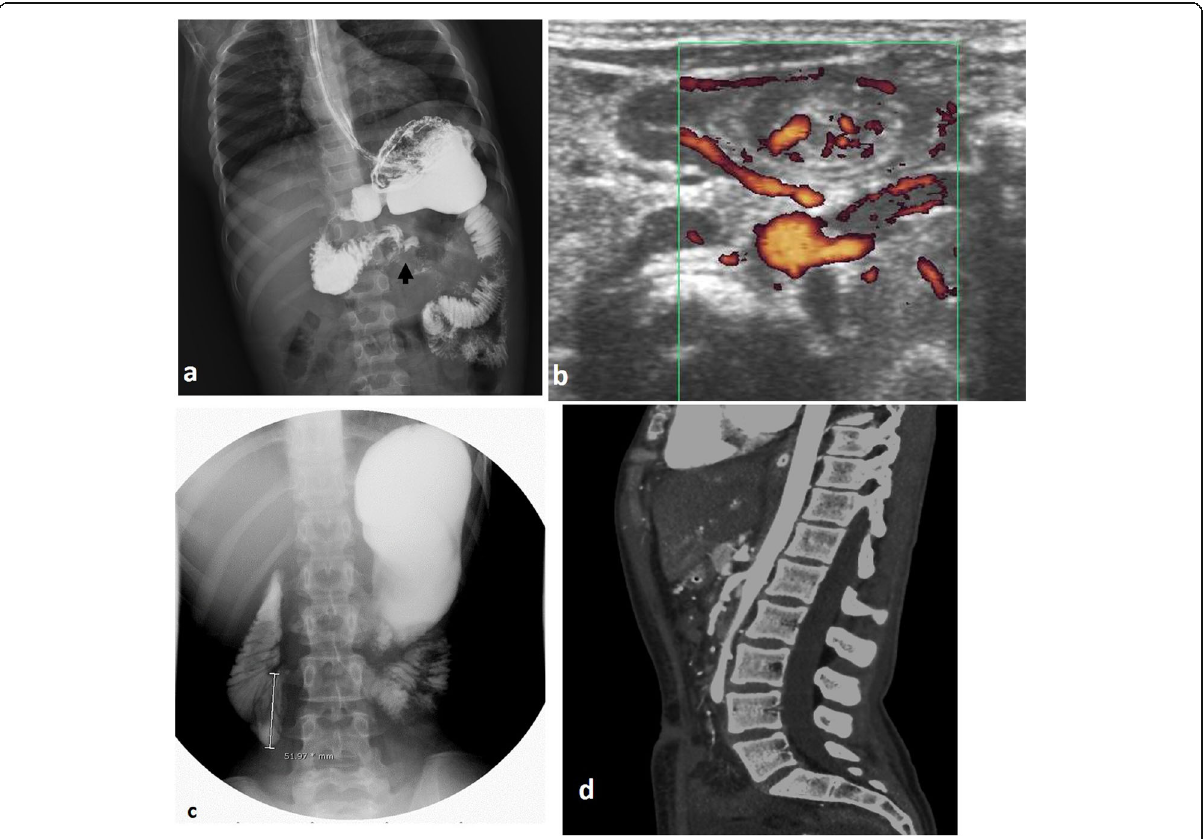
Fig. 4 UGI series of two different patients with duodenal abnormalities presenting with bilious vomiting. a Case of intestinal malrotation and midgut volvulus (arrow). b Ultrasound and Doppler transverse sonogram showing “ whirl ” -like pattern of small bowel loops. c , d A case of superior